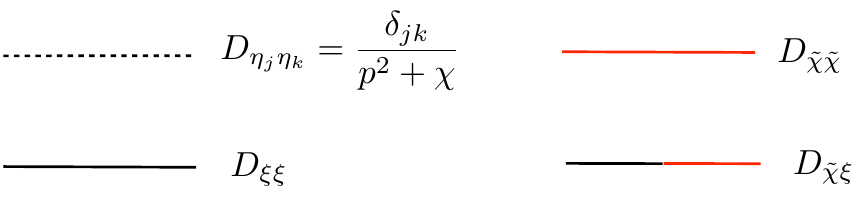
Figure 4 . The propagators for the e(cid:11)ective Lagrangian (2.42).